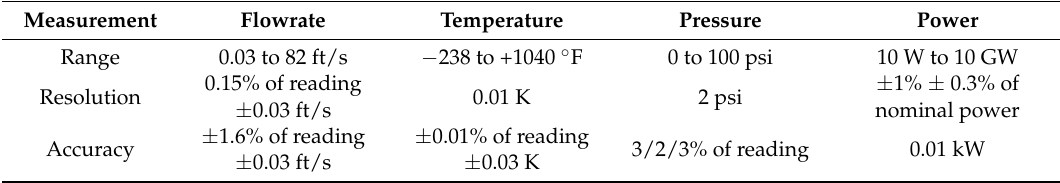
Table 3. Specifications for each type of measurement.